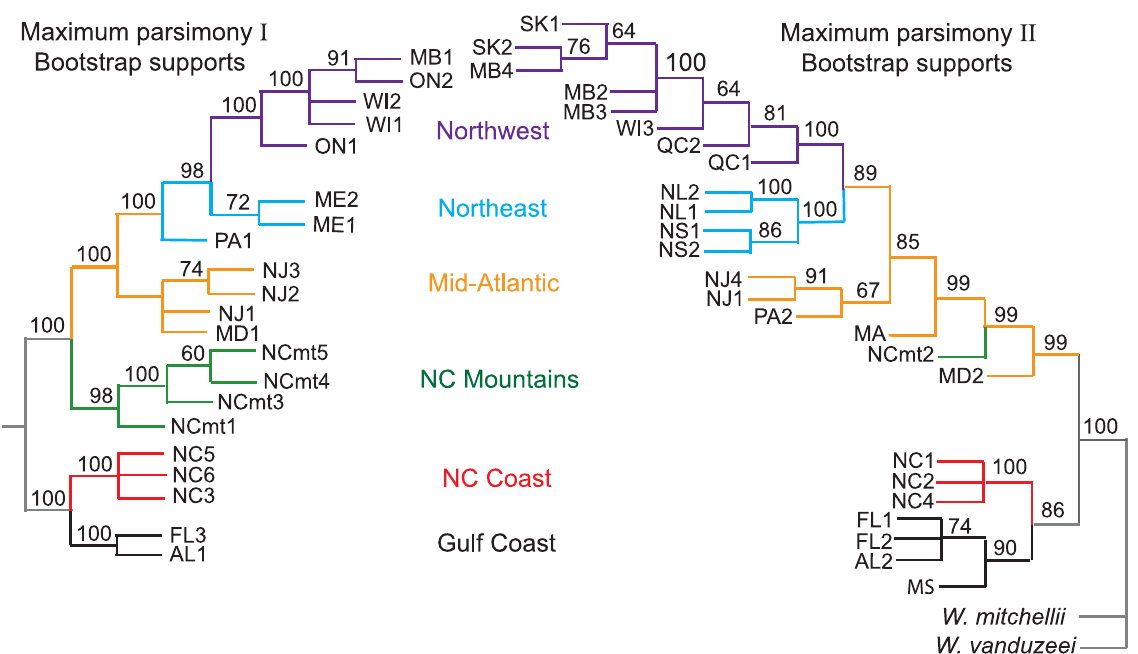
Figure 2. Replicability of maximum parsimony trees. Left , phylogenetic tree from [1] using 21 populations and 54 bp reads. Right , phylogenetic tree from the current study using 25 populations and 80 bp reads. Colors and abbreviations as in Figure 1. Nodal values show bootstrap support . 50%.